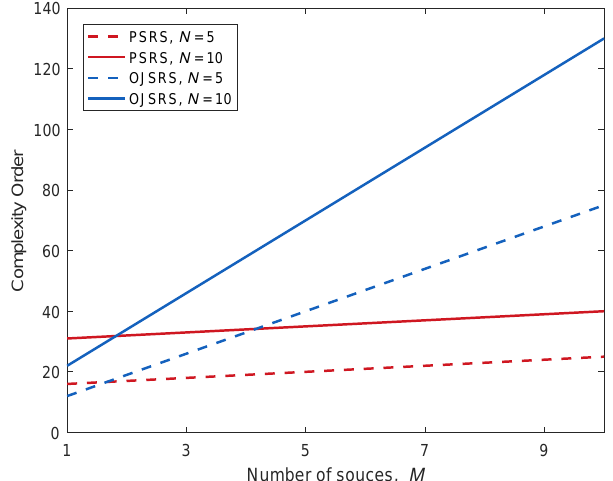
Figure 7. Comparison of the complexity order between the PSRS and OJSRS